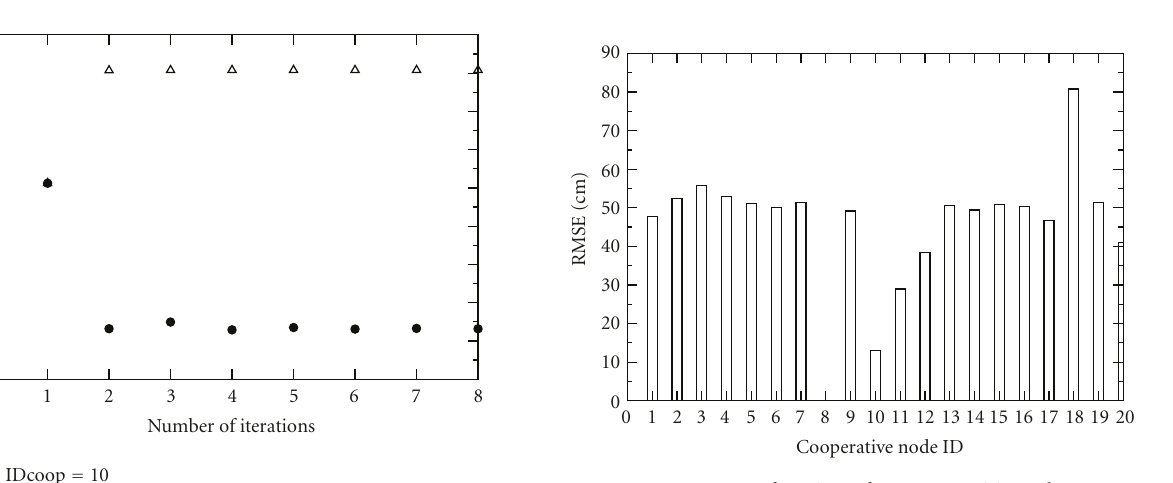
Figure 10: RMSE as a function of target 2 position when target 1, located in position 8, cooperates with target 2; N = 3 (tx1,tx3,tx5) beacons are considered, N iter =